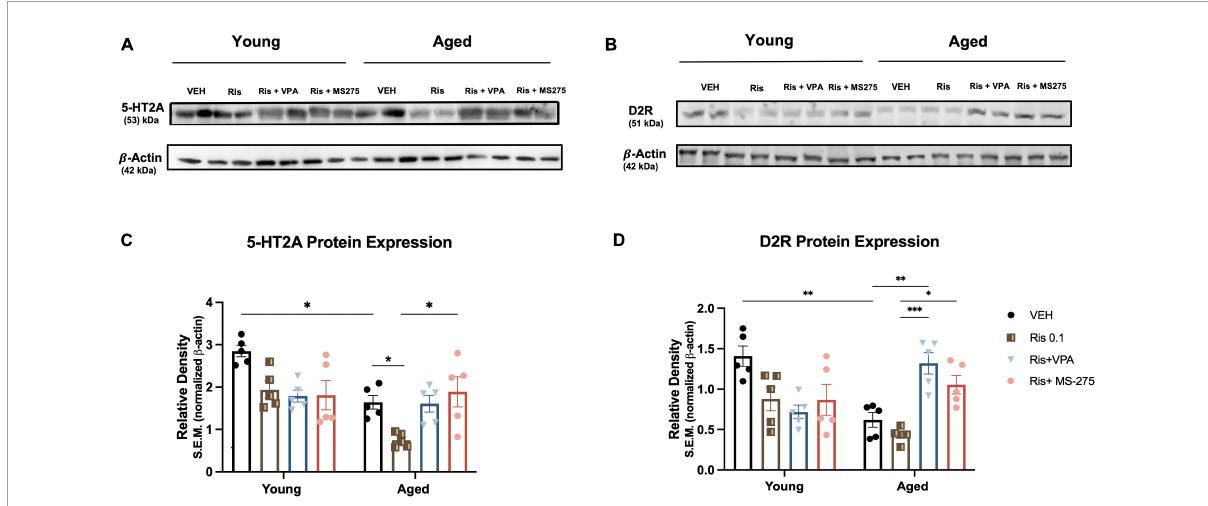
FIGURE3 Effects of histone deacetylase (HDAC) inhibitors on 5-HT2A and D2R protein expression in the striatum of young and aged mice. (A, C) 5-HT2A expression was significantly decreased in the striatum in aged mice but not young mice, RIS further induced decreased expression in of 5-HT2A expression in aged mice. Co-treatment of RIS with VPA and MS-275 could restore 5-HT2A expression in aged mice. (B, D) D2R expression was decreased in the striatum in aged mice as compared to young mice administration of both VPA and MS-275 with RIS significantly increased D2R expression in the striatum as compared to Veh and RIS treated aged mice. Data represent mean ± SEM ( n = 5). ∗ p < 0.05, ∗∗ p < 0.01, ∗∗∗ p <